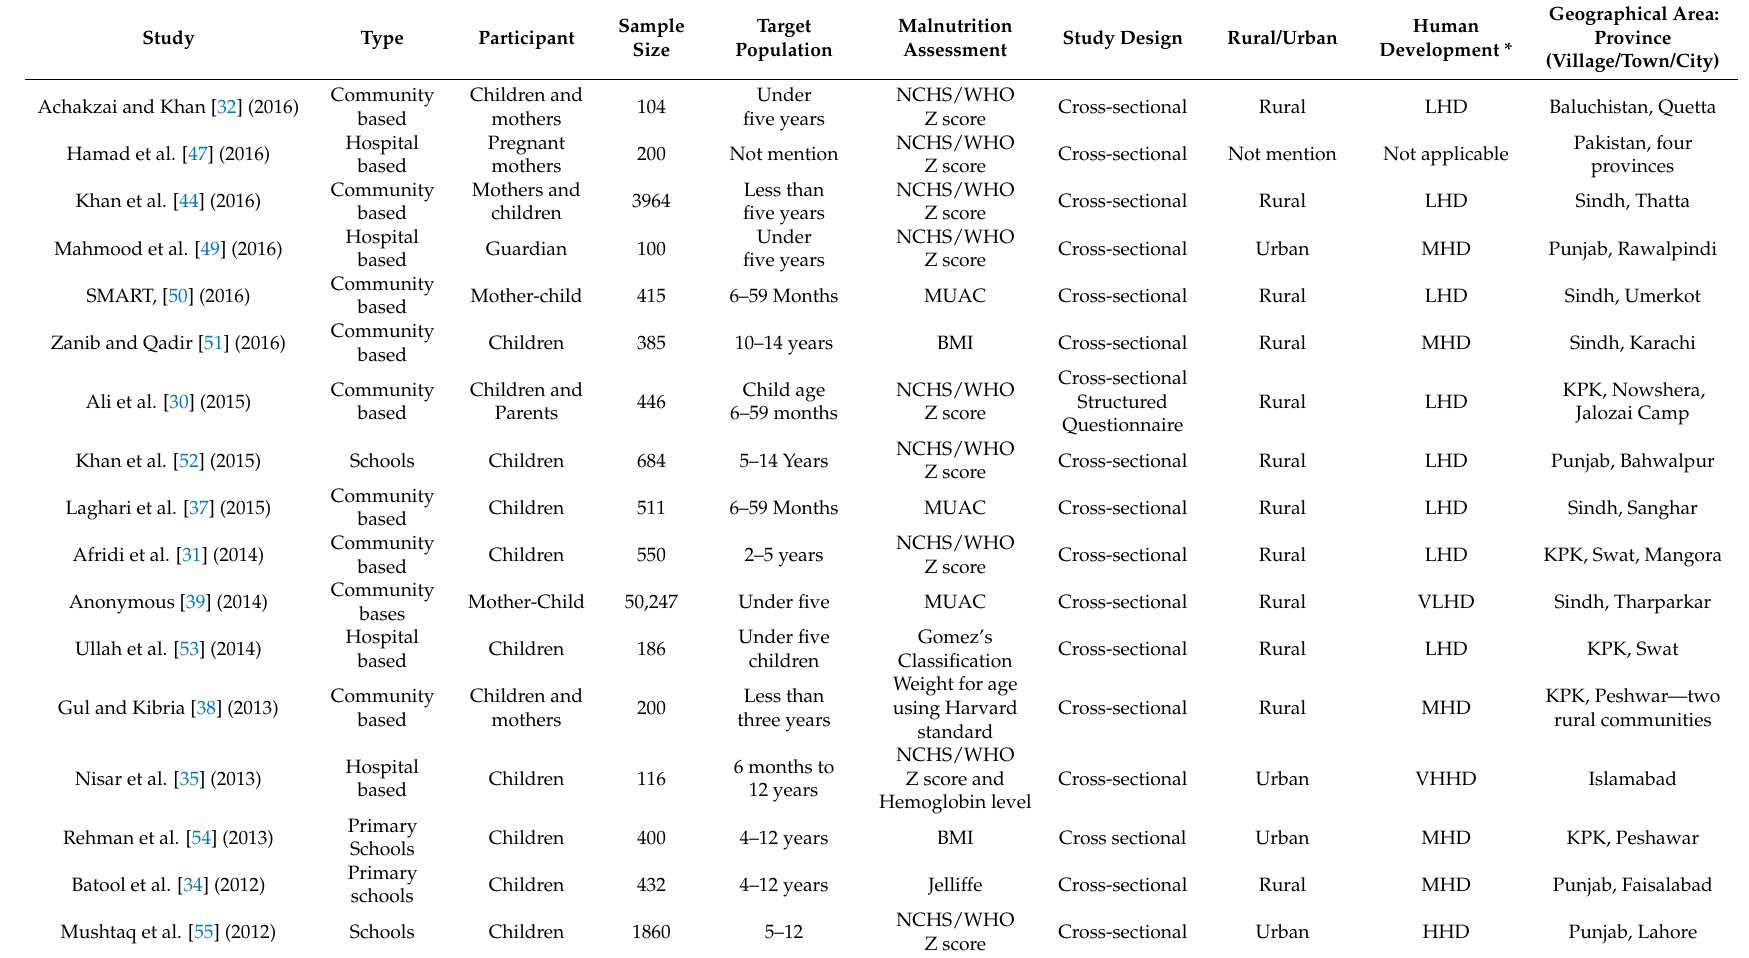
Table 1. Description of the studies included in the